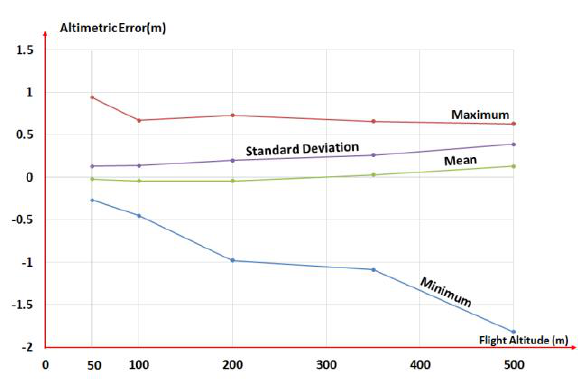
Figure A6: Accuracy of DSM UAV accuracy extracted from multiple flight altitudes comparing to Total Station